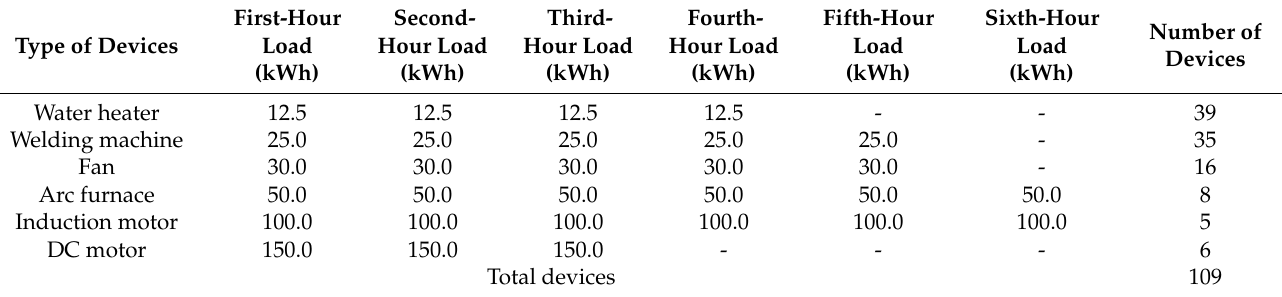
Table 2. Controllable loads present for the industrial area.